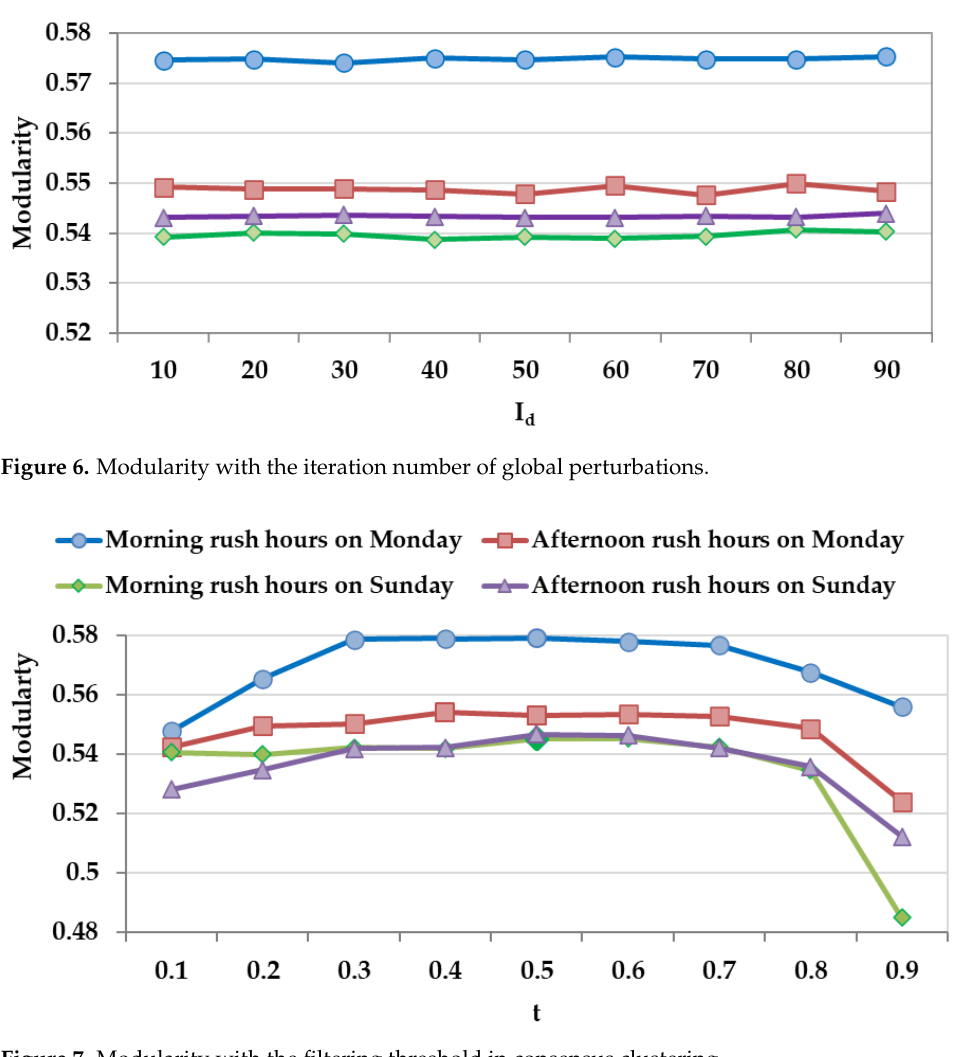
Figure 7. Modularity with the filtering threshold in consensus clustering.